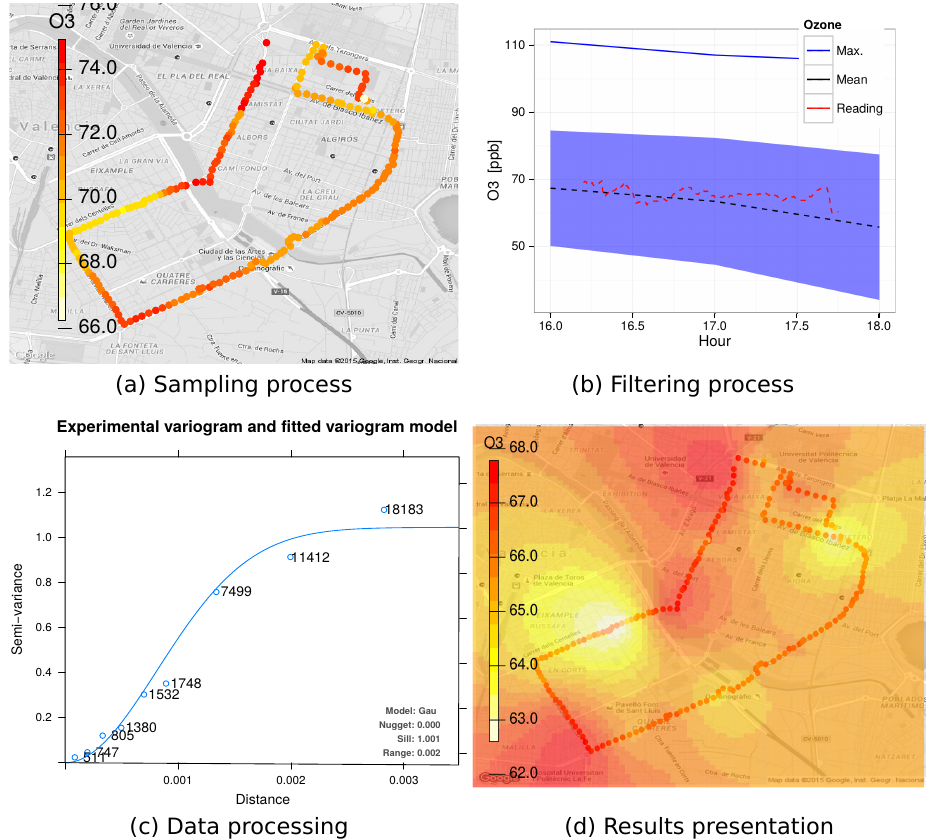
Figure 10. Data handling process as described in [68]: ( a ) sampling process; ( b ) filtering process after adjusting the temporal variations; ( c ) data analysis using a semivariogram of the captured data used for interpolating the entire area using the Kriging technique; and ( d ) pollution distribution